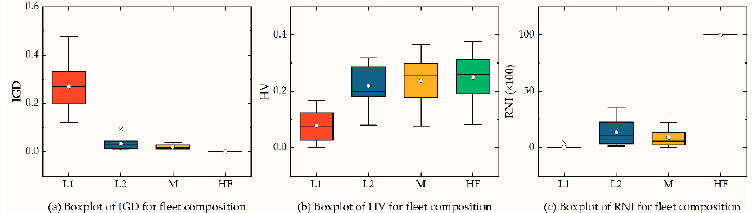
Figure 4. Boxplot of IGD, HV, and RNI values of each fleet composition.